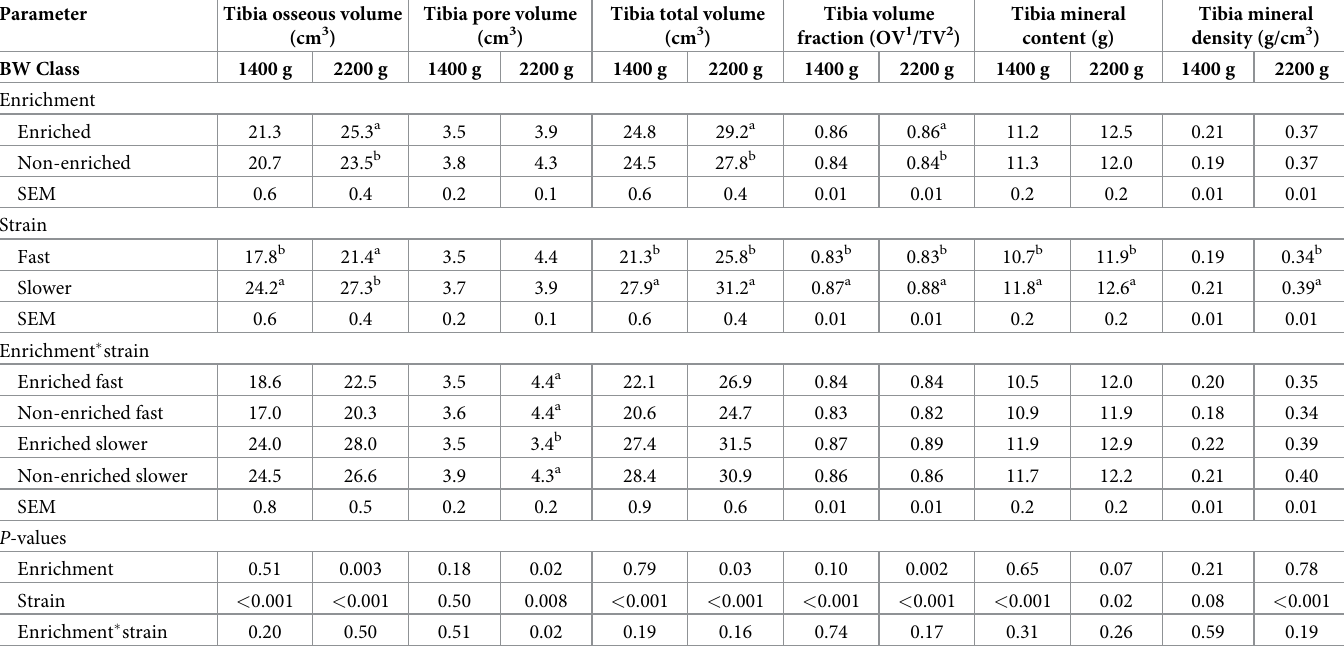
Table 4. Effects of pen enrichment (enriched or non-enriched), broiler strain (fast-growing ross 308 or slower-growing Hubbard JA 757) and their interaction on tibia biophysical characteristics of male broiler chickens in two body weight classes (1400 and 2200 g) (2 chickens per pen, n = 7 pens per treatment, LSmeans ±